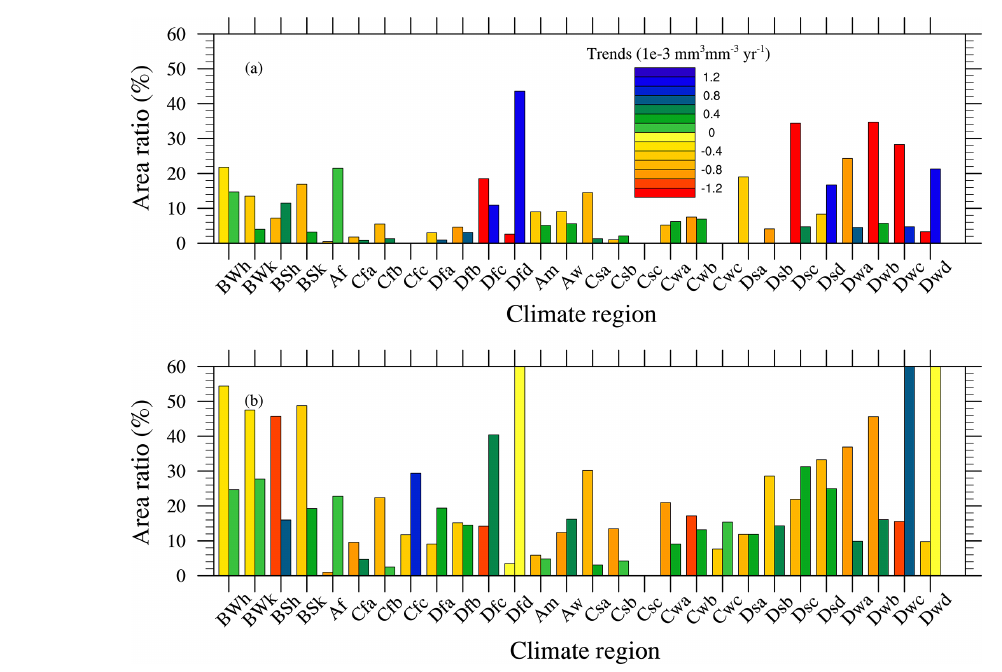
Figure 7. Statistics of the soil moisture trends. (a, b) The ratio of surface and deep soil moisture to wet and dry conditions for 28 Köppen– Geiger climate types. For each type, the left bar is the drying ratio and the right bar is the wetting